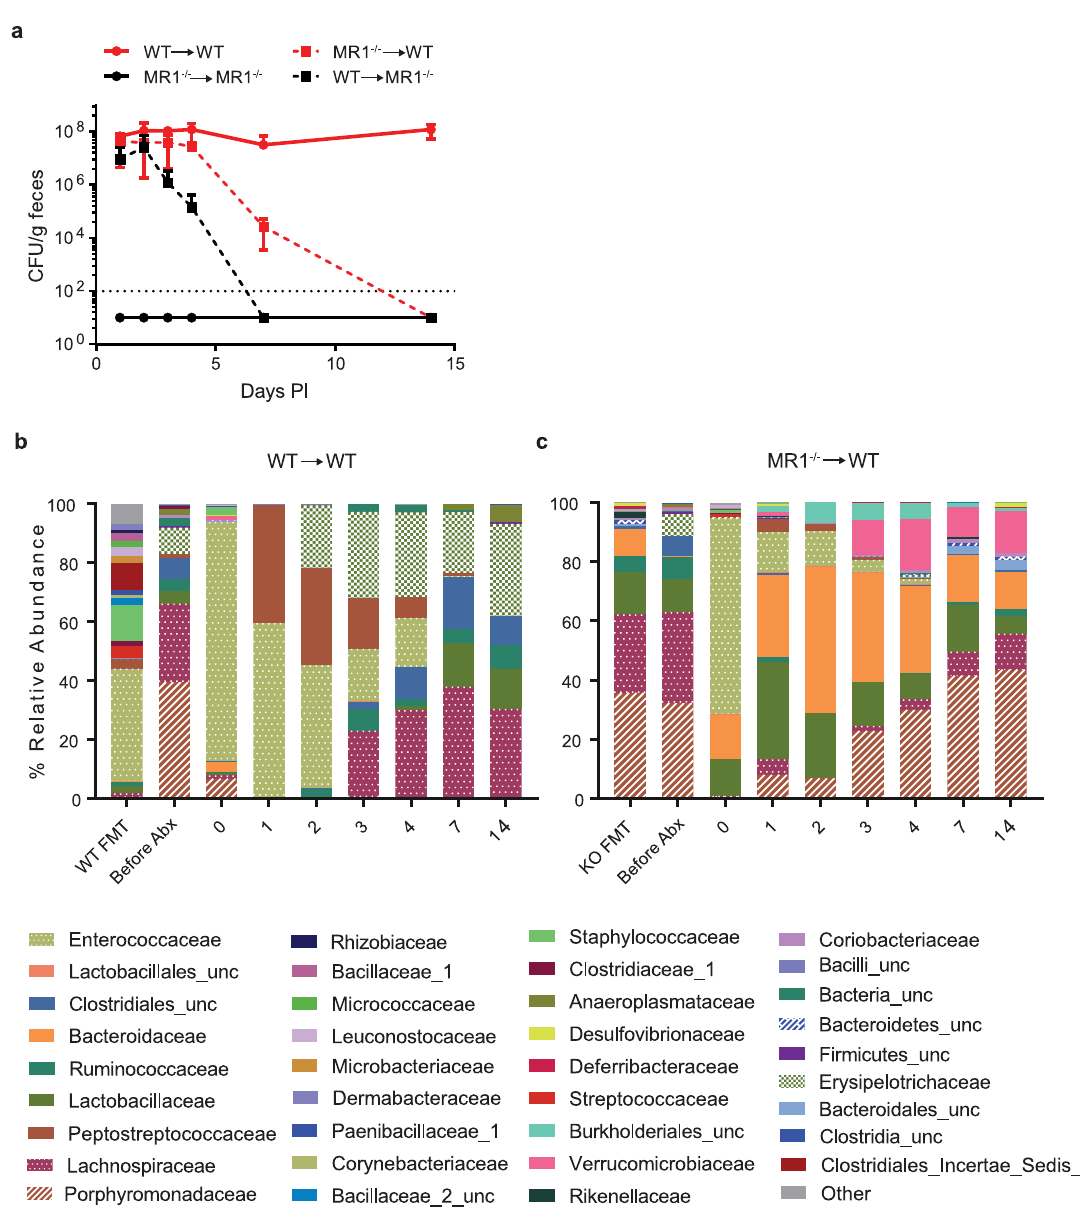
Fig 7. Cd colonization resistance is transferrable to susceptible mice. (A) WT and MR1 -/- mice were treated as pictured in Fig 1d and then taken off cefoperazone one day prior to FMT administration. Each strain was divided into two groups and inoculated with antibiotic treated stool from either autologous stool, or stool from the opposite strain. Colonization levels were tracked over time (B & C). Assessment of microbiota composition over time following FMTMR1 -/- ! MR1 -/- n = 3, WT ! MR1 -/- n = 3, WT ! WT n = 4 MR1 -/- ! WT n = 3. Data presented are mean ± SD of one